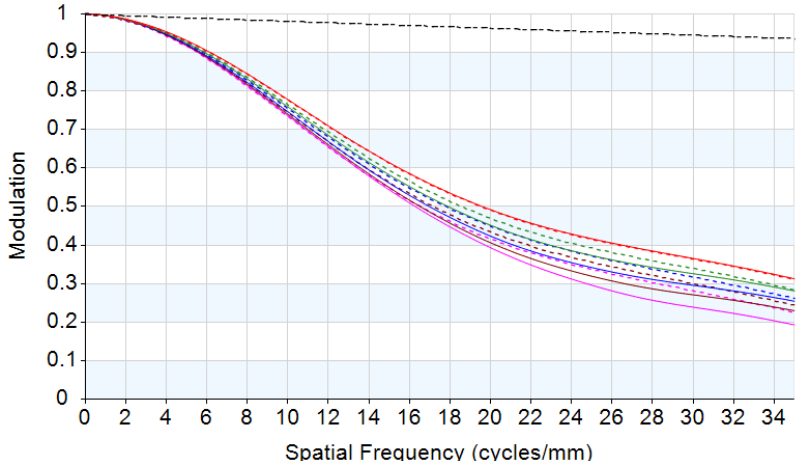
Figure 6. MTF graph of the athermal visible lens at − 70 °C considering thermal-induced surface deformation.